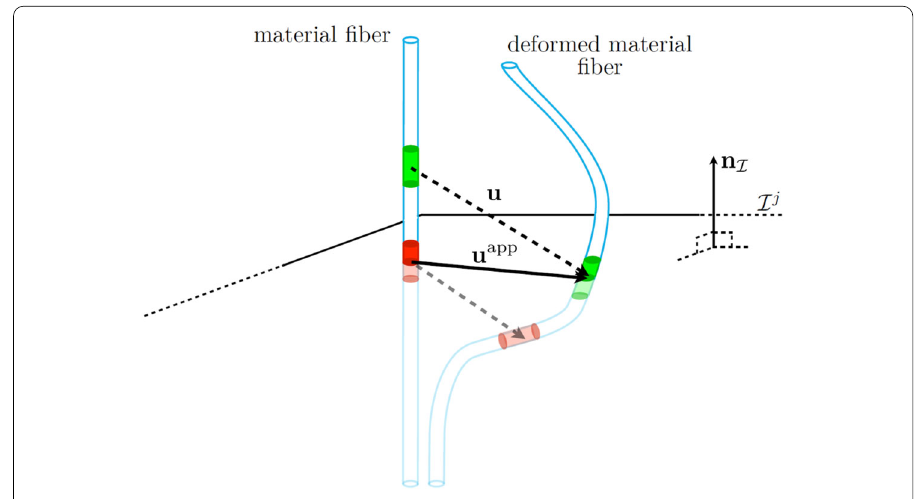
Fig. 5 Illustration of the difference between material displacement u and apparent displacement u